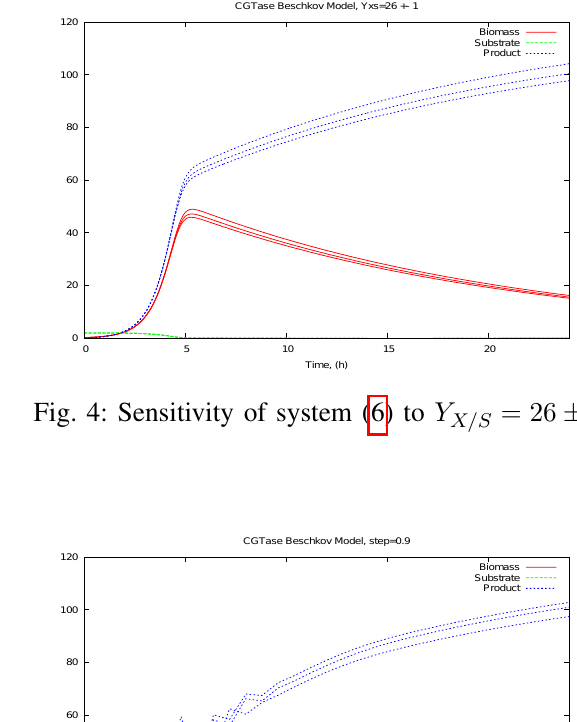
Fig. 1: Sensitivity of system (6) to s 0 = 2 ± 0 . 2